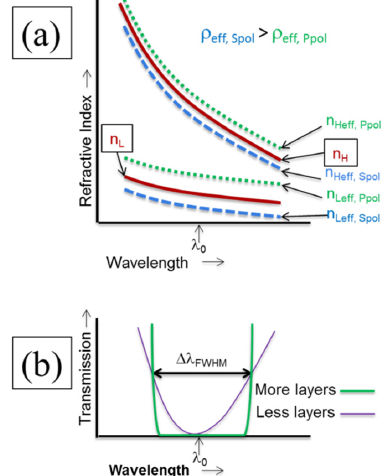
Figure 1. ( a ) Schematic depicting the dispersive variation with wavelength of the index of refraction and the effective for S polarization (Spol) and P polarization (Ppol) indices for non-normal angle of incidence (AOI) for the H and L index layers of a BBHR coating. See the text for explanation of the labels; ( b ) Schematic depicting two transmission spectra for a BBHR coating, one of more and the other of less layers, as indicated. λ 0 is the center wavelength of the spectra. The bandwidth label refers to the BBHR counterpart to the bandwidth, Δλ FWHM , of quarter ‐ wave HR coatings, for which Δλ FWHM / λ 0 = (2 Δ g )/[1 − ( Δ g ) 2 ] where Δ g depends on polarization and, for Spol(Ppol), is given by